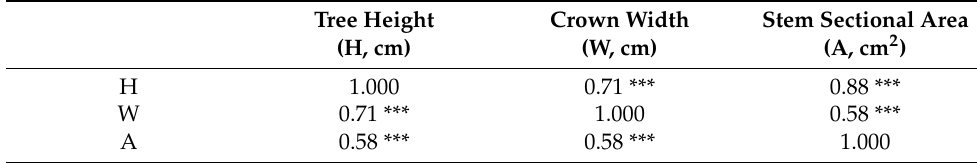
Table 3. Results of the repeated analysis carried out on yield response